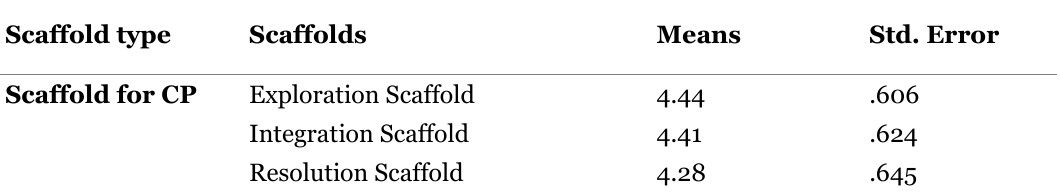
Scaffold type Scaffold for CP